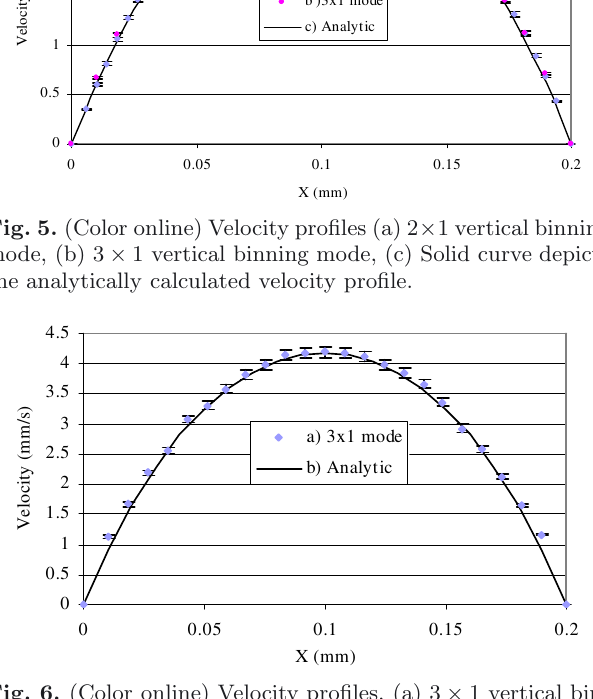
Fig. 6. (Color online) Velocity profiles, (a) 3 × 1 vertical bin- ning mode, (b) solid curve depicts the analytically calculated velocity